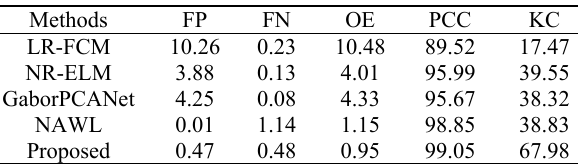
Table 2. Results (%) and comparison of various methods on Luchengxiang dataset.